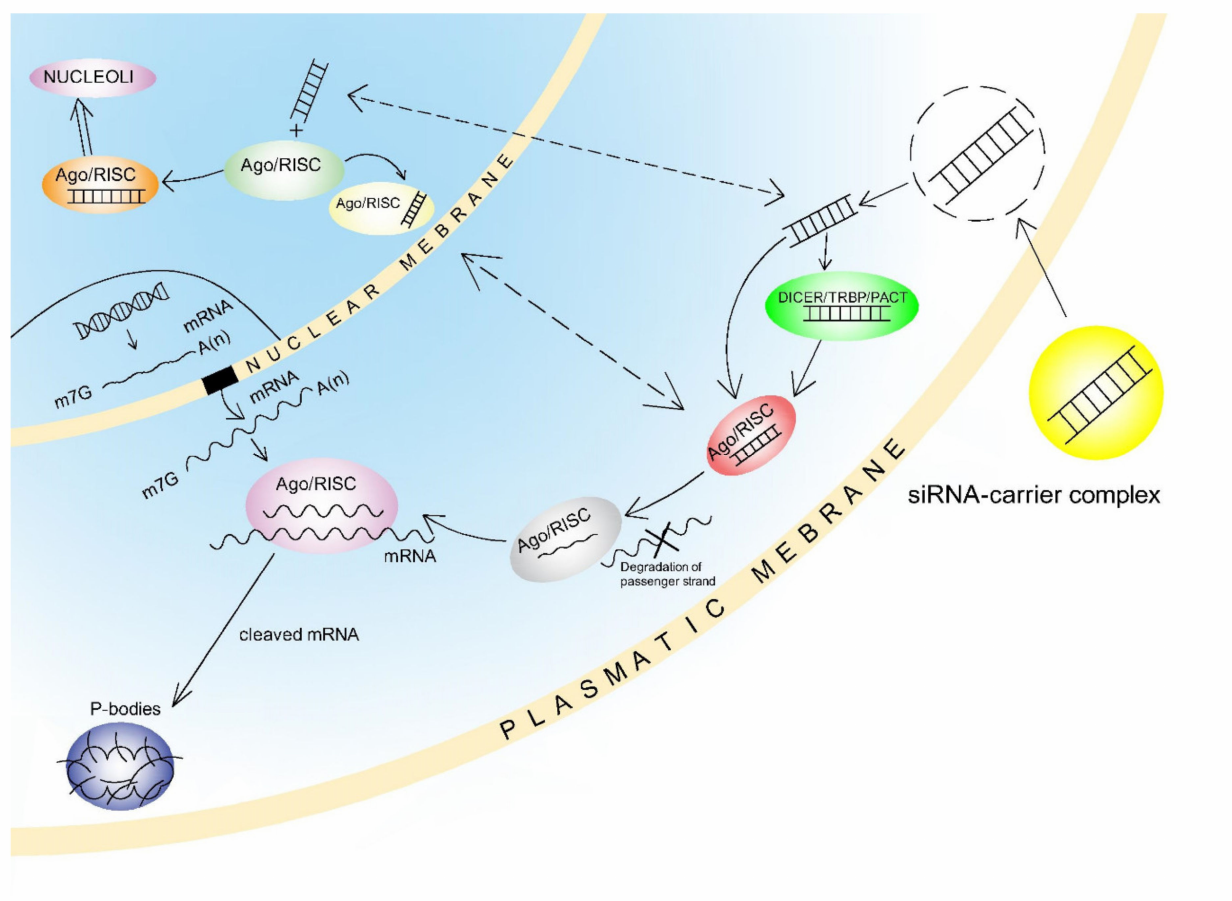
Figure 4. siRNA action mechanism. Following delivery to the cytoplasm, the siRNA’s are directly loaded into the RISC complex or they undergo Dicer-mediated processing before loading in the RISC complex. Guide strand selection and passenger strand degradation depend on the several properties The guide strand has weaker binding at the 5 (cid:48) -end, is U-biased at that end and also has excess purines. The Ago/RISC complex then recognises the target mRNA and this is cleaved and degraded, or its translation is suppressed by sequestration in P-bodies. The presence of both individual siRNAs and those loaded in the Ago/RISC complex in the transfected cells’ nucleus has been noted, and there is also shuttling of this complex between cytoplasm and nucleus. The precise mechanisms of these actions require elucidation. Edited with permission from